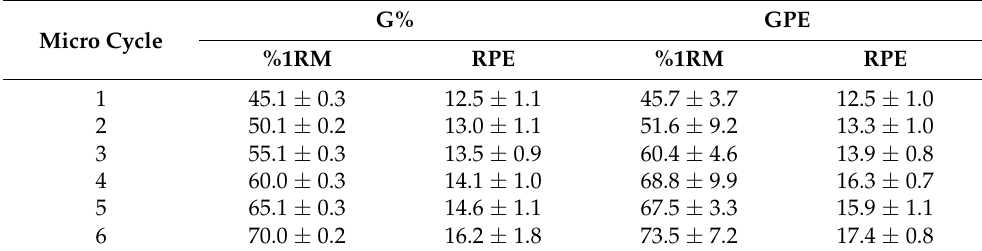
Table 3. Mean ± standard deviation of the load as percentage of a single repetition maximum (%1RM) and as Perceived Exertion (RPE) for all exercises and sessions of each micro cycle.